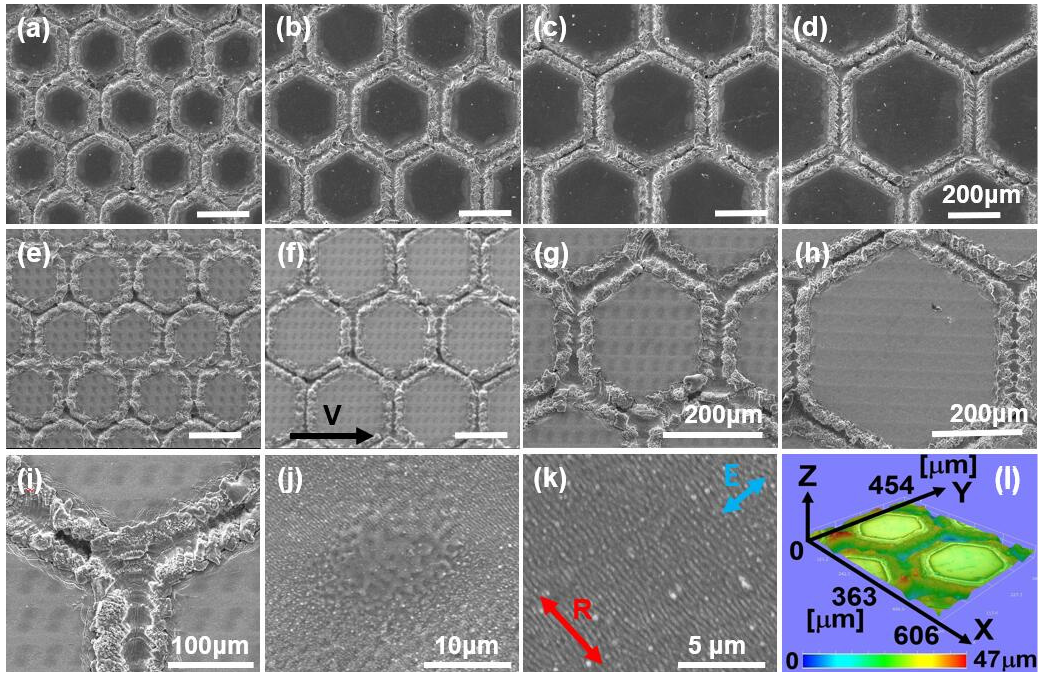
Figure 2. ( a – d ) SEM images of surface morphology of Ti-6Al-4V samples with an array of micro-hexagons at di ff erent side lengths of the hexagon: 150 µ m, 200 µ m, 250 µ m and 300 µ m, respectively, fabricated directly by the microsecond laser at the same fluence of 2000 J / cm 2 at the scanning speed of 100 mm / min (scale bar is 200 µ m in the subfigures). ( e – h ) SEM images of the surface morphology of the Ti-6Al-4V samples with both an array of micro-hexagons at di ff erent side lengths of the hexagon: 150 µ m, 200 µ m, 250 µ m and 300 µ m, respectively, and fs-LIPSS fabricated by the fs laser at the same fluence of 6.34 J / cm 2 at the scanning speed of 200 mm / s and scanning intervals of 50 µ m after microsecond laser processing (scale bar is 200 µ m in the subfigures; the arrow V in ( f ) indicates the scanning direction of the fs laser). ( i ) SEM image of the surface morphology in the area between the micro-hexagons in the enlarged view of ( f ). ( j ) SEM image of the surface morphology of the black spot within the micro-hexagon in the enlarged view of ( f ). ( k ) SEM image of the nano-ripples in the enlarged view of ( f ) (the arrow E indicates the polarization direction of the fs laser; the arrow R indicates the orientation of the nano-ripples). ( l ) Three-dimensional morphology of ( f ).